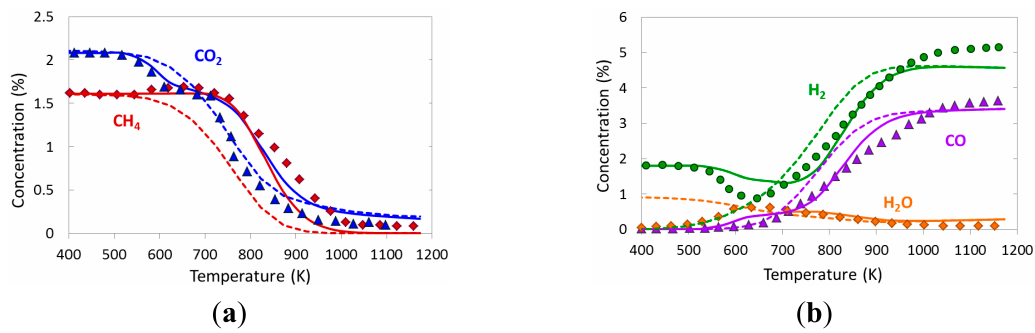
Figure 12. Comparison of experimentally determined (symbols) and numerically predicted (lines) concentrations as a function of temperature for catalytic dry reforming of methane with co-feed H 2 : ( a ) CH 4 and CO 2 ; ( b ) H 2 O, CO, H 2 , inlet gas composition of 1.6 vol.% CH 4 , 2.1 vol.% CO 2 , 1.8 vol.% H 2 in N 2 ; 1 bar; T inlet = 373 K; total flow rate of 4 slpm; dashed lines = equilibrium composition at given